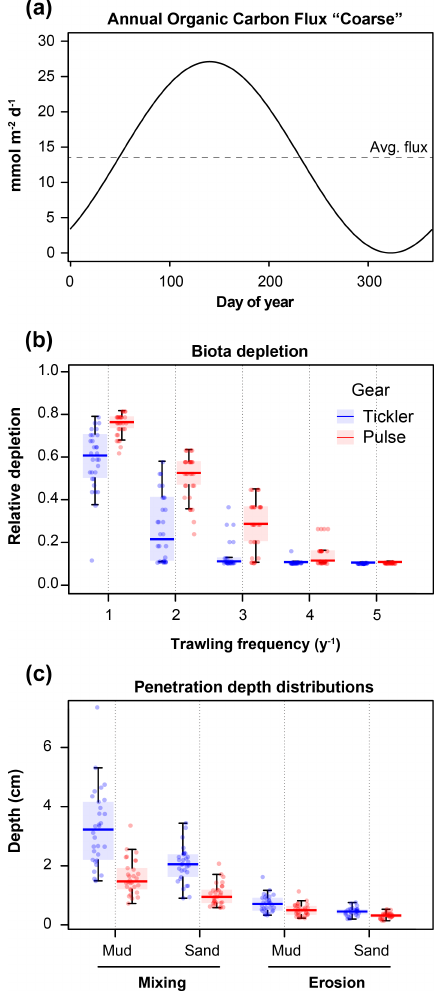
Figure 2. (a) Example of sinusoidal varying organic carbon depo- sition flux, based on average DIC efflux measured by Toussaint et al. (2021) for the Coarse sediment. (b) Simulated depletion of bio- turbation, relative to the maximum ( y axis), with increasing trawl- ing frequency (yr − 1 , x axis) in fine sands. (c) Imposed mixing and erosion depths (cm), for fine sandy and muddy sediments, for the two gear types (tickler chain and pulse gear).